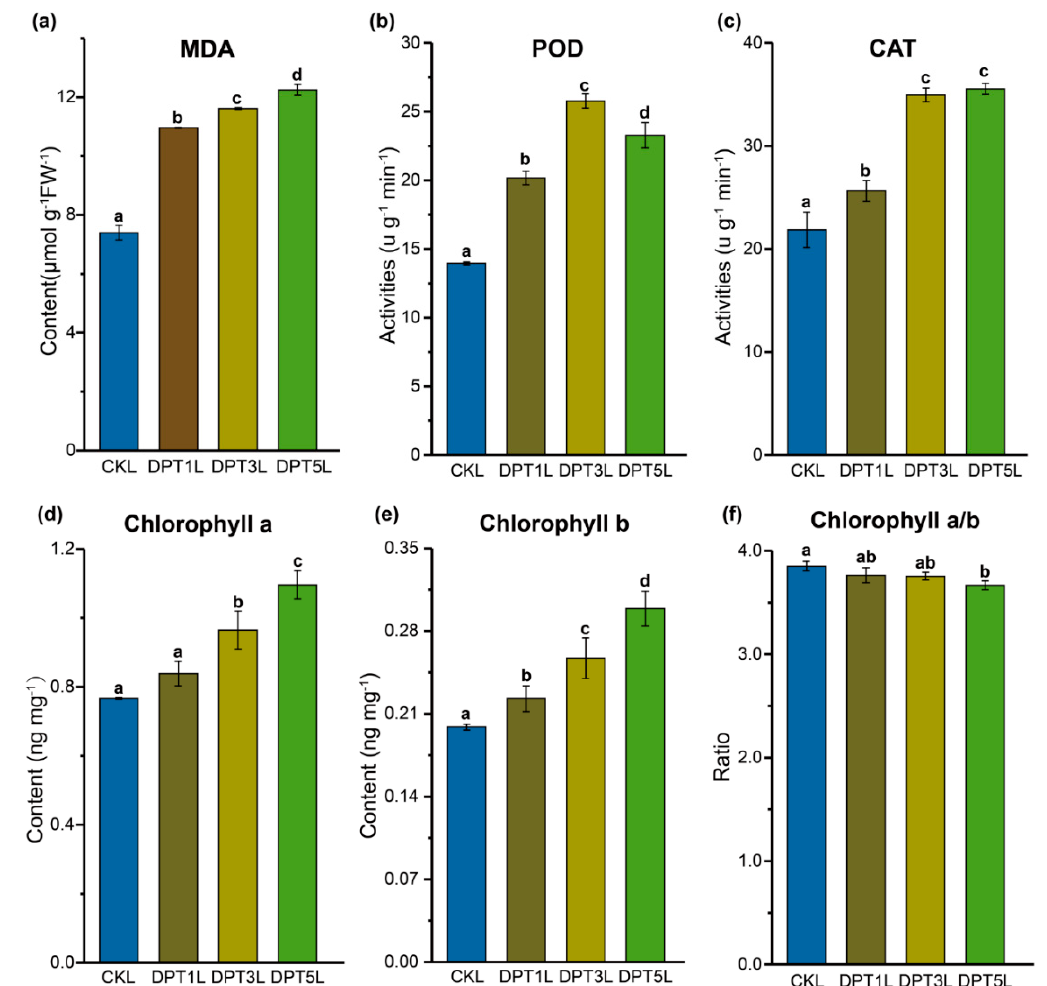
Figure 2. Changes in physiology in cotyledons of common buckwheat seedlings under different drought stress conditions. ( a ) Changes in the malondialdehyde (MDA) content of cotyledons, ( b ) changes in the peroxidase (POD) activities of cotyledons, ( c ) changes in the catalase (CAT) activities of cotyledons, ( d ) chlorophyll a content in the cotyledons, ( e ) chlorophyll b content in the cotyledons, and ( f ) ratios of chlorophyll a/b.